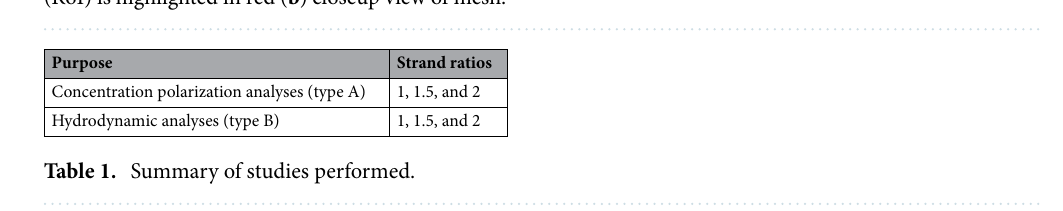
Figure 1. Computational domain ( a ) with strand ratio, R of ‘1’(above) and R of ‘2’ (below), region of interest (RoI) is highlighted in red ( b ) closeup view of mesh.